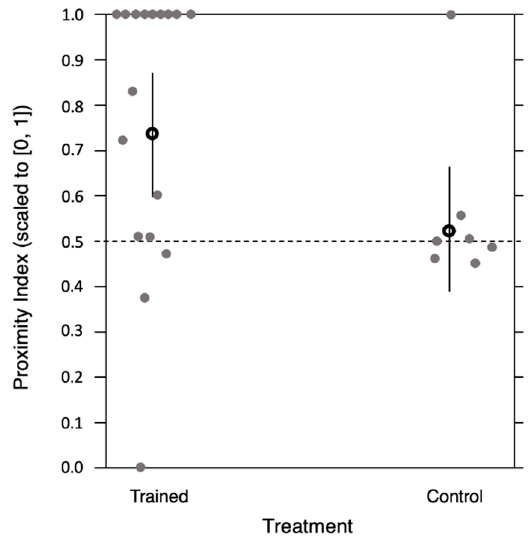
Figure 3. Selective attention to live demonstrators was not influenced by amount of time demonstrators were on the floor. Proximity index (scaled to [0, 1]) represents the total number of proximity instances in relation to the total amount of time each live demonstrator spent on the floor and, therefore, was available for the observer to follow. Trained observer bees selectively attended to the type of live demonstrator that was previously associated with reward and control bees trained on the vertical flowers without the presence of any demonstrators did not show preference for either of the different artificially-modified (yellow- or blue-painted thorax) demonstrators. Open circles represent model estimates (0.73 for trained bees and 0.53 for control bees) for both and error bars represent confidence levels at 95% (0.60 to 0.87 for trained bees and 0.39 to 0.67 for control bees); each grey circle represents Proximity indexes (scaled to [0, 1]) for individual bees. The horizontal dashed line indicates the chance level (no preference).